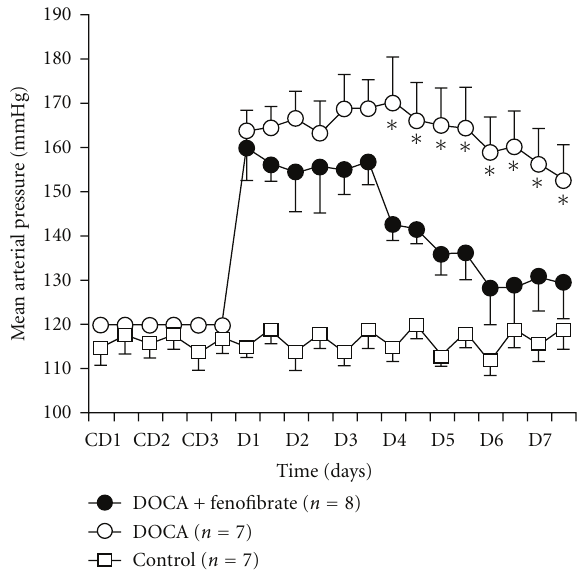
Figure 1: Mean arterial pressure during a seven-day treatment period in control mice, DOCA-salt-treated (1.5 mg/g) group and a DOCA + fenofibrate-treated (500mg/kg/day) group. C: control days, D: DOCA salt days ( ∗ P < 0 . 05).